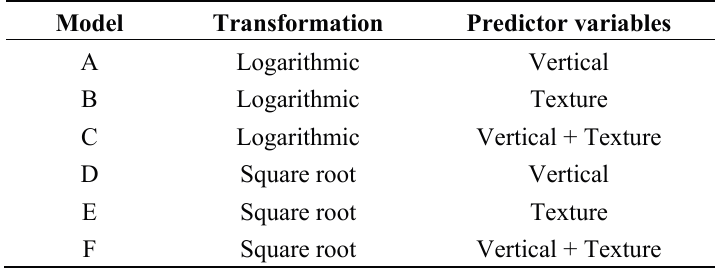
Table 3. Summary of tested model forms and predictor